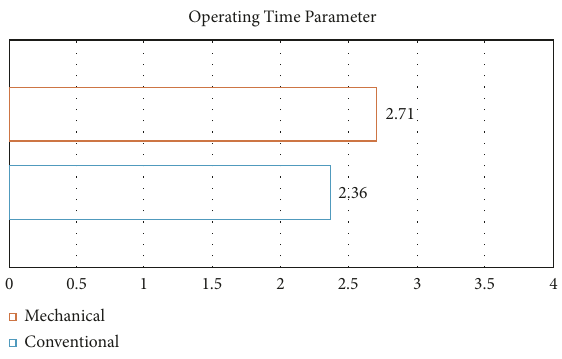
Figure 3: Operating time